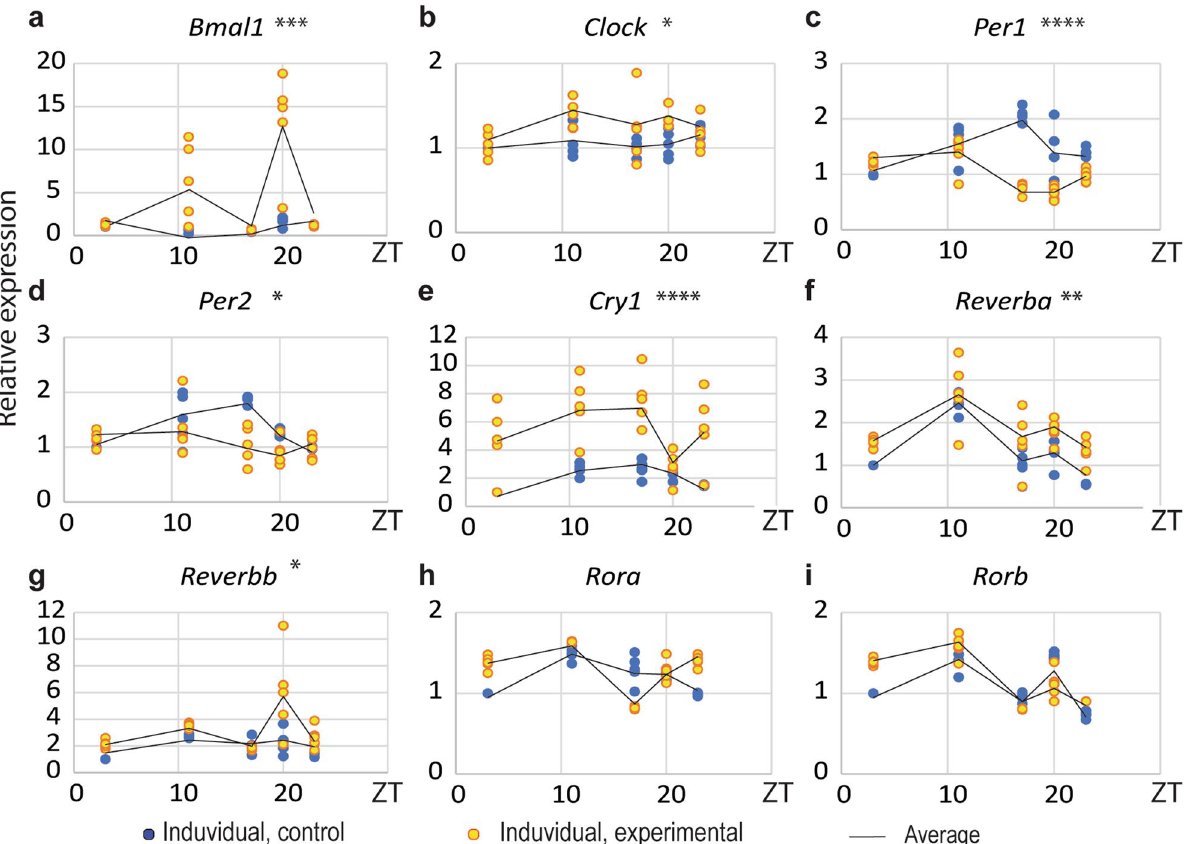
Figure 4. CD changed clock genes expression. Leydig cells from both groups were individually isolated at different time points for 24 h. RQ-PCR analysis of clock genes were performed in the second day of the light period in the CD protocol. CD changed diurnal transcriptional rhythms: increased positive regulators Bmal1 ( a ) and Clock ( b ) and negative Cry1 ( e ), Reverba ( f ) and Reverbb ( g ) but also decreased Per1 ( c ) and Per2 ( d ) in ZT11 and ZT17. Transcription of Rora ( h ) and Rorb ( i ) were unaltered. Statistical significance: *p < 0.05; **p < 0.01; ***p < 0.005; ****p < 0.001 determined by two-way